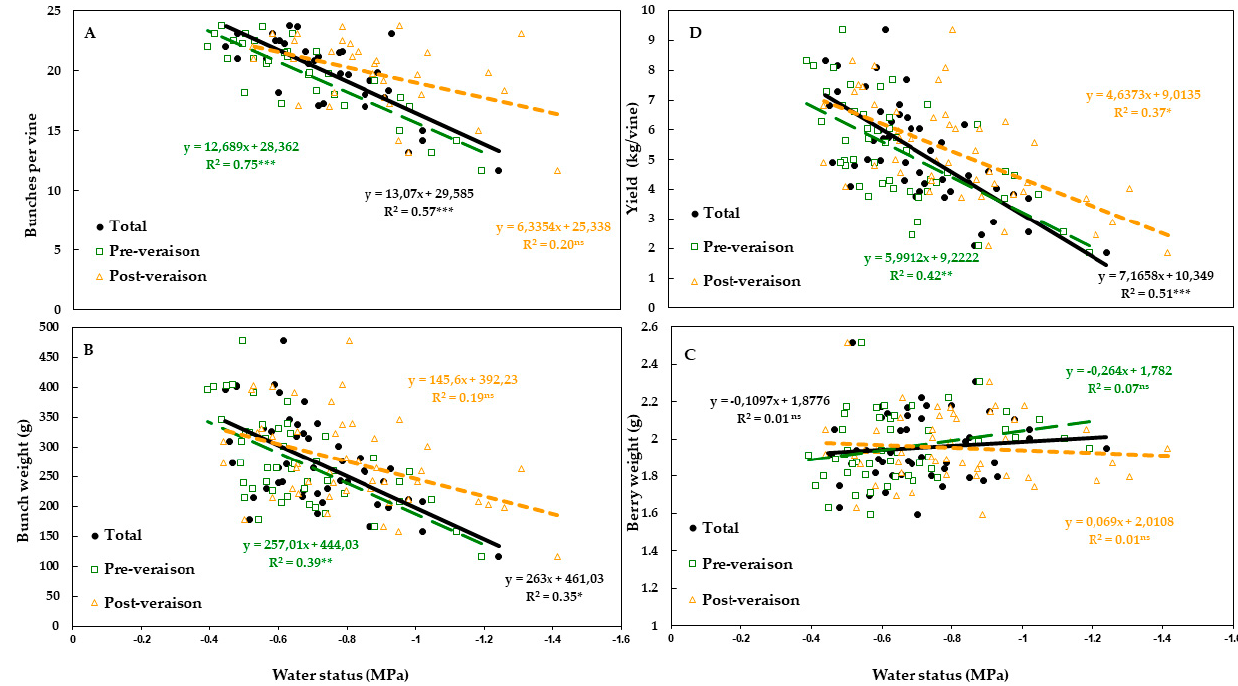
Figure 5. Relationships between annual water status, in pre-veraison and post-veraison, of the high load treatments, with production parameters: number of bunches per vine ( A ), fresh bunch weight (g) ( B ), fresh berry weight (g) ( C ), and yield in fresh weight (kg/vine) ( D ). In the case of the number of clusters, this was compared with the previous year’s water status. *, **, ***, indicate that the factor was significant at p < 0.05, p < 0.01, and p < 0.001, respectively; ns, not significant.